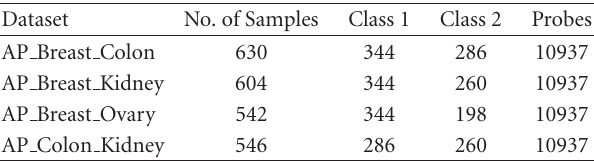
Table 1: Overview of GEMLeR datasets used in this